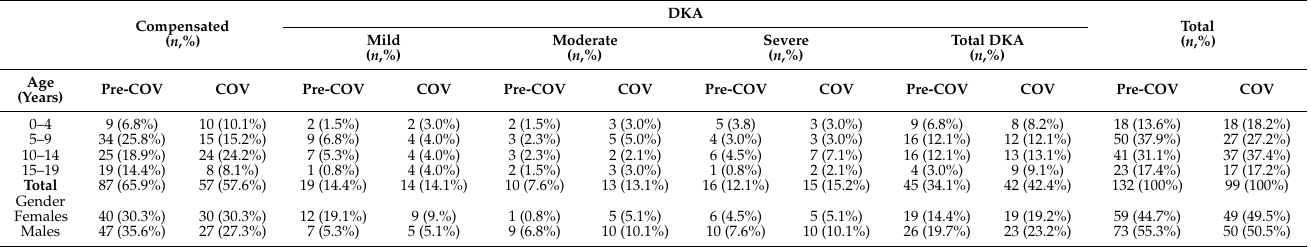
Table 2. Presenting state at diagnosis by age categories and gender during